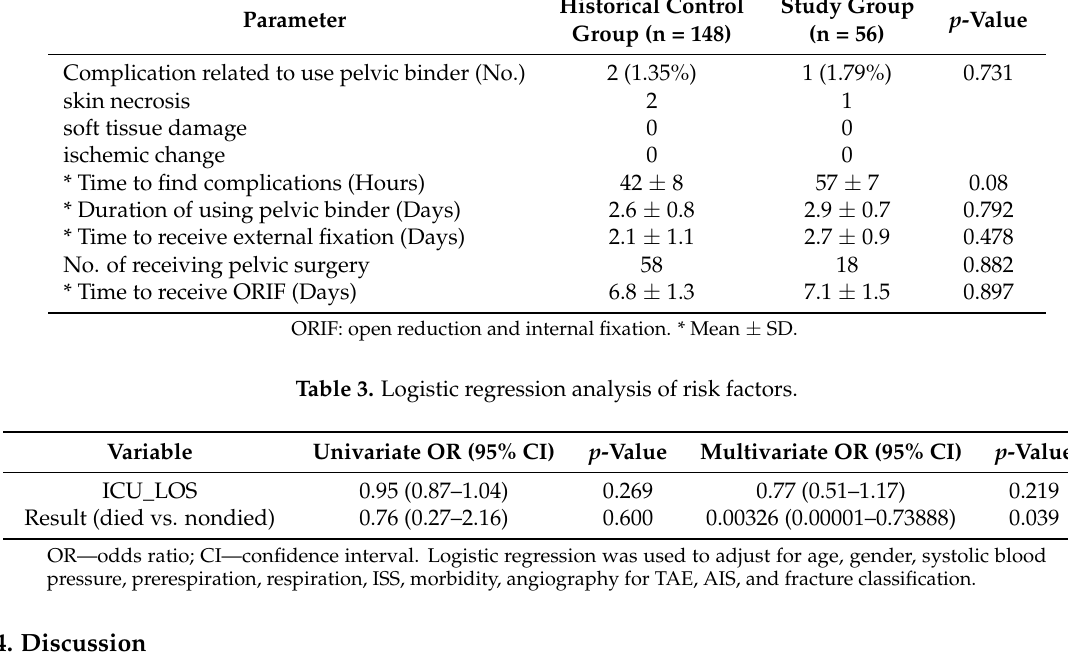
Table 2. A comparison of the study group with the historical control group of using pelvic binders. Parameter